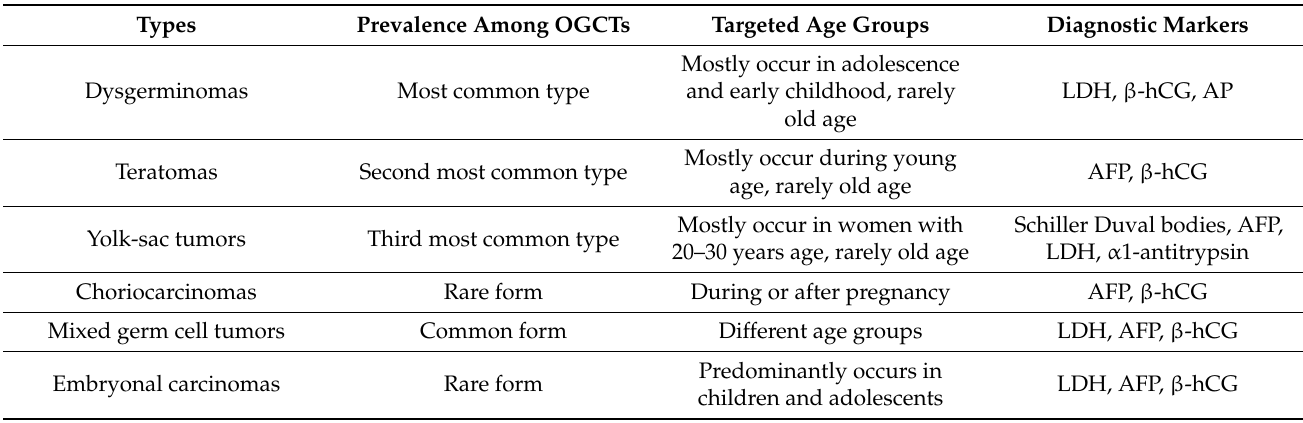
Table 1. Ovarian germ cell tumors: Types, prevalence, targeted age groups and diagnostic markers. Abbreviations: OGCTs: ovarian germ cell tumors; LDH: Lactic dehydrogenase; β -hCG: Beta-human chorionic gonadotrophin; AP: Alkaline phosphatase; AFP: Alpha